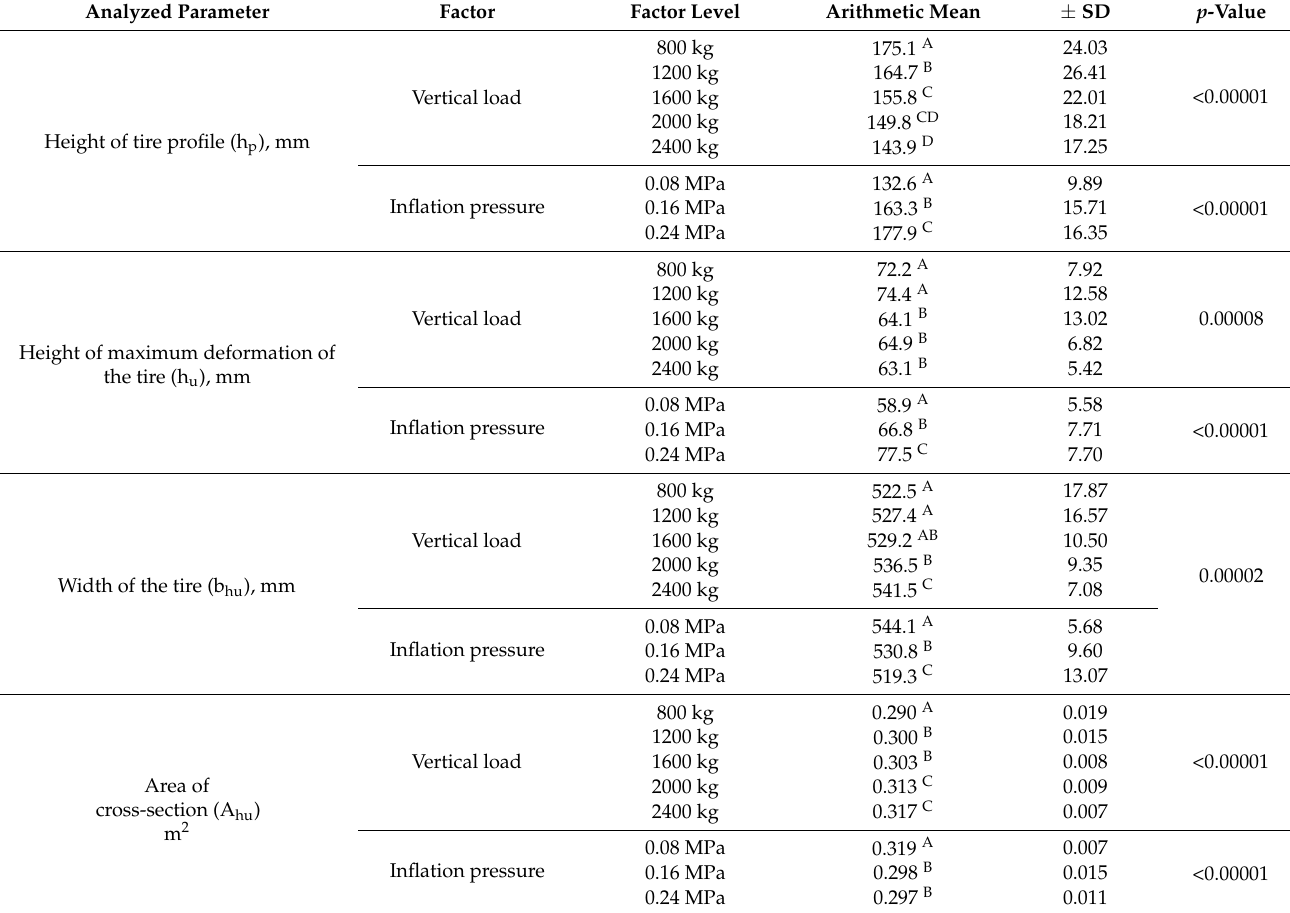
Table 2. Results of statistical analysis for radial tire, significance level α = 0.05, SD—standard deviation. Analyzed